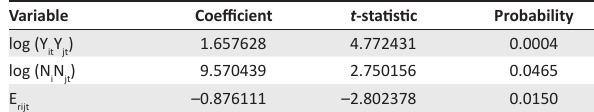
TABLE 3: Estimation